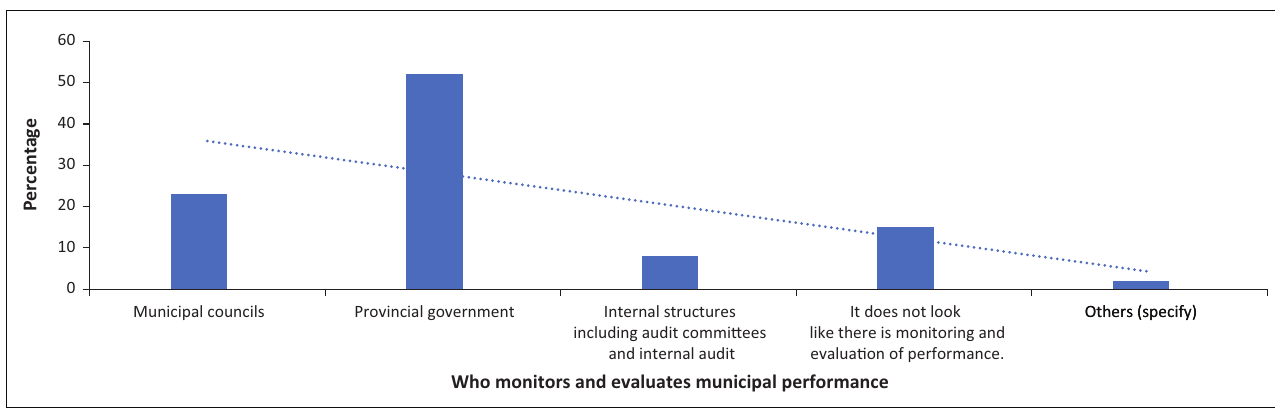
FIGURE 2: Budget expenditure.